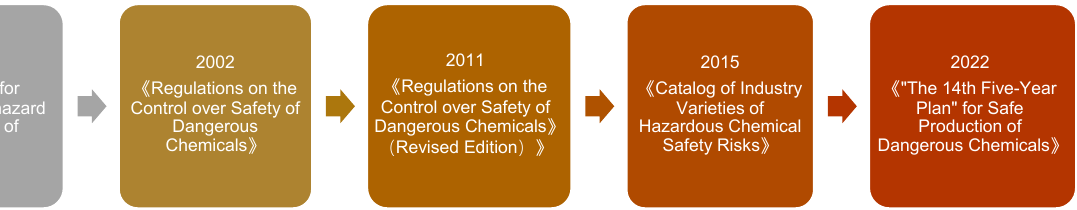
Figure 11. China’s hazardous chemical industry safety standards construction history.